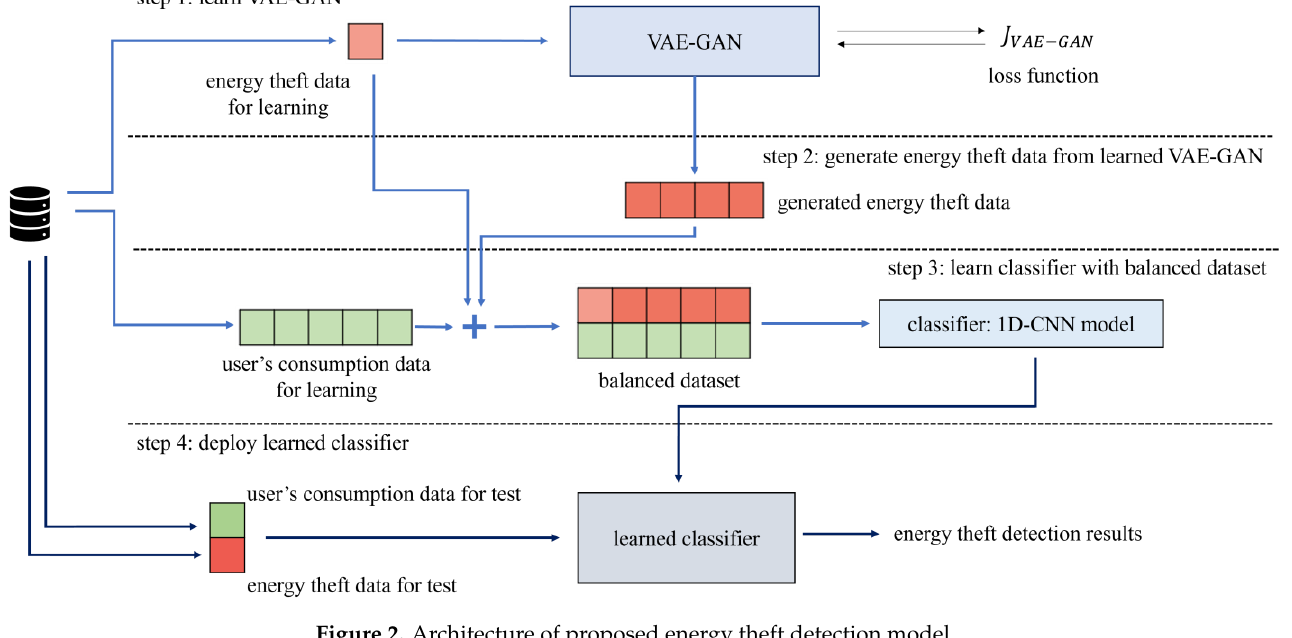
Figure 2. Architecture of proposed energy theft detection model.